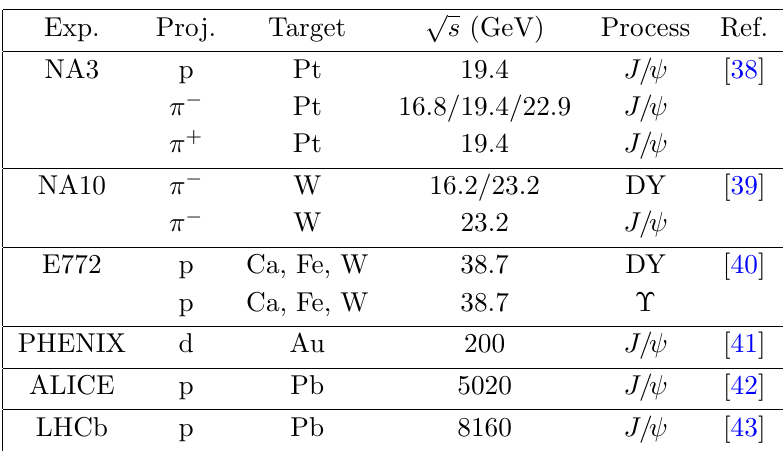
Table 2 . Data sets included in the present